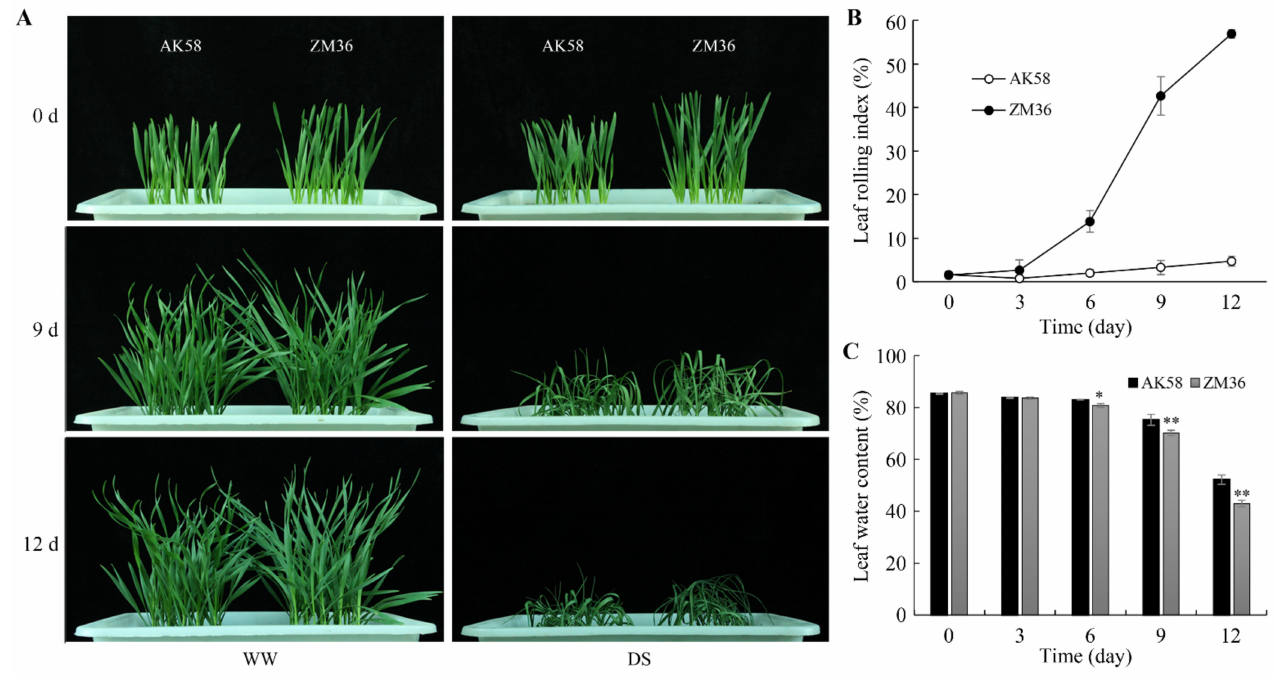
Figure 1. Under drought stress, the leaf rolling of ZM36 was more serious than that of AK58. ( A ) The seedling phenotype of the AK58 and ZM36 under WW (well-watered) and DS (drought stress) for 0, 9 and 12 d. ( B ) Leaf rolling index of AK58 and ZM36 under DS. ( C ) Leaf water contents of AK58 and ZM36 under DS. Data represent means ± SE. Error bars indicate SE. *, t -test with p < 0.05; **, t -test with p <